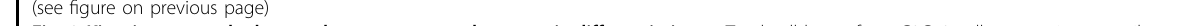
Fig. 3 Kinesin-1 controls dexamethasone-promoted myogenic differentiation. a Total cell lysate from C2C12 cells expressing non-silenced (shCon) or Kinesin-1-silenced (shKIF5B) shRNAs were analyzed by western blotting using antibodies against kinesin-1, α -tubulin, and GAPDH. b Effects of kinesin-1-silencing on Dex-enhanced mitochondria dynamics. C2C12 cells expressing non-silenced (shCon) or Kinesin-1-silenced (shKIF5B) shRNAs were treated with the indicated concentrations of Dex for 1 h. Data are mean ± s.e.m (shCon in 0 µM Dex, n = 3481 mitochondria/6 cells; shCon in 1 µM Dex, n = 4716 mitochondria/6 cells; shKIF5B in 0 µM Dex, n = 3847 mitochondria/6 cells; shKIF5B in 1 µM Dex, n = 3578 mitochondria/6 cells). *** p < 0.001. c C2C12 cells expressing non-silenced (shControl) or Kinesin-1-silenced (shKIF5B) shRNAs were treated with the indicated concentrations of Dex for 6 h and immunostained for Tom20 (green; to visualize mitochondria), phalloidin (red; to visualize F-actin), and DAPI (blue; to visualize nucleus). Scale bar, 10 µm. d The mitochondria area (marked with Tom20) as a percentage within a cell (marked with phalloidin), as shown in c . Data are mean ± s.e.m (shCon in 0 μ M Dex, n = 29 cells; shCon in 1 μ M Dex, n = 30 cells; shKIF5B in 0 μ M Dex, n = 30 cells; shKIF5B in 1 μ M Dex, n = 30 cells). * p < 0.05; *** p < 0.001; NS no signi fi cance. e Effects of kinesin-1 silencing on Dex-enhanced myogenic differentiation. C2C12 cells expressing non-silenced (shControl) or Kinesin-1-silenced (shKIF5B) shRNAs were treated with differentiation medium containing the indicated concentrations of Dex for 3 days and analyzed by western blotting using antibodies against MYH1/2, kinesin-1, and GAPDH. f Effects of kinesin-1 on Dex-promoted myoblast fusion. C2C12 cells expressing non-silenced (shControl) or Kinesin-1-silenced (shKIF5B) shRNAs were treated with differentiation medium containing the indicated concentrations of Dex for 5 days and immunostained for MYH1/2 (yellow; myotube marker) and DAPI (to visualize nucleus). Scale bar, 100 µm. g Fusion index, calculated as the percentage of nuclei ( ≥ 3) in MYH1/2 + cells, as shown in f . Data are mean ± s.e.m (shControl in 0 µM Dex, n = 313 MYH1/2 + cells; shControl in 0.1 µM Dex, n = 236 MYH1/2 + cells; shControl in 1 µM Dex, n = 192 MYH1/2 + cells; shKIF5B in 0 µM Dex, n = 104 MYH1/2 + cells; shKIF5B in 0.1 µM Dex, n = 84 MYH1/2 + cells; and shKIF5B in 1 µM Dex, n = 79 MYH1/2 + cells). ** p < 0.01; *** p < 0.001; NS no signi fi cance. h Effects of the association between kinesin-1 and microtubules on Dex-enhanced myogenic differentiation. C2C12 cells were treated with differentiation medium containing the indicated concentrations of Dex and kinesin-1 inhibitor RBL for 3 days and analyzed by western blotting using antibodies against MYH1/2, and GAPDH (internal control). The ratio of MYH1/2 to GAPDH is shown as fold. i C2C12 cells were treated with differentiation medium containing 40 µM RBL for 3 days and analyzed by western blotting using antibodies against MYH1/2, α -tubulin, kinesin-1, and β -actin. j Effects of the association between kinesin-1 and microtubules on Dex-promoted myoblast fusion. C2C12 cells were treated with differentiation medium containing the indicated concentrations of Dex accompanied with either DMSO (control) or 40 µM RBL for 5 days and immunostained for MYH1/2 (yellow; myotube marker) and DAPI (to visualize nucleus). Scale bar, 100 µm. k Fusion index, calculated as the percentage of nuclei ( ≥ 3) in MYH1/2 + cells, as shown in j . Data are mean ± s.e.m (DMSO in 0 µM Dex, n = 144 MYH1/2 + cells; DMSO in 0.1 µM Dex, n = 160 MYH1/2 + cells; DMSO in 1 µM Dex, n = 157 MYH1/2 + cells; RBL in 0 µM Dex, n = 130 MYH1/2 + cells; RBL in 0.1 µM Dex, n = 164 MYH1/2 + cells; RBL in 1 µM Dex, n = 34 MYH1/2 + cells). * p < 0.05; *** p < 0.001; NS no signi fi